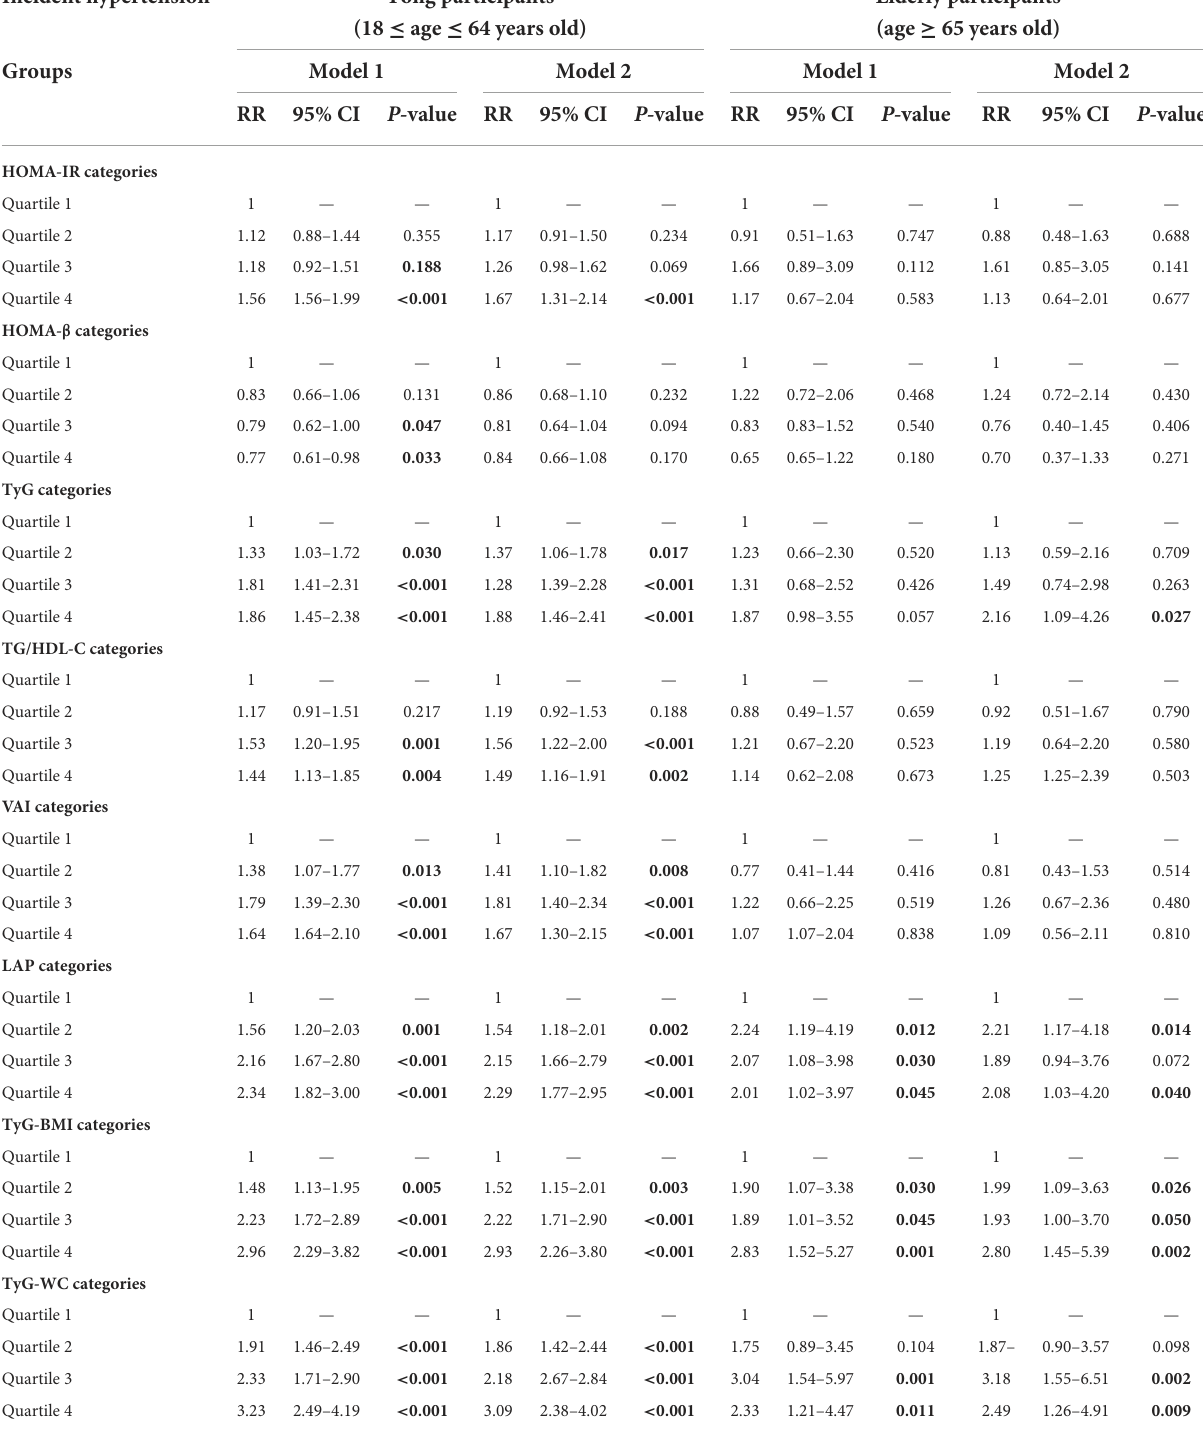
TABLE 4 Risk ratios and 95% confidence intervals of the association of IR categories and its surrogate index with incident hypertension by age periods. Incident hypertension Yong participants Elderly participants (18 ≤ age ≤ 64 years old) (age ≥ 65 years old) Groups Model 1 Model 2 Model